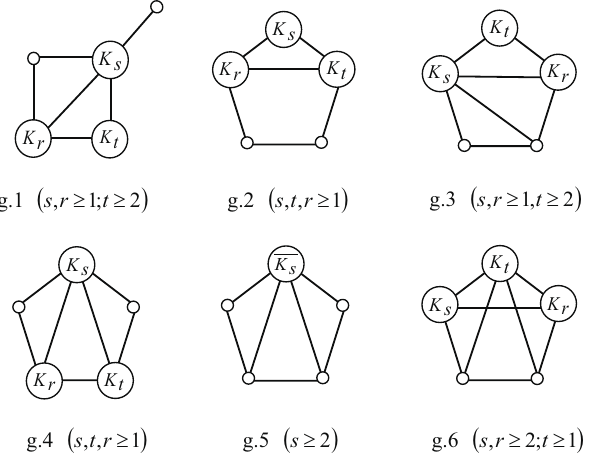
Figure 3. All graphs of d ( G ) = 2, n ( G T ) = 5 and dim ( G ) = n ( G ) −